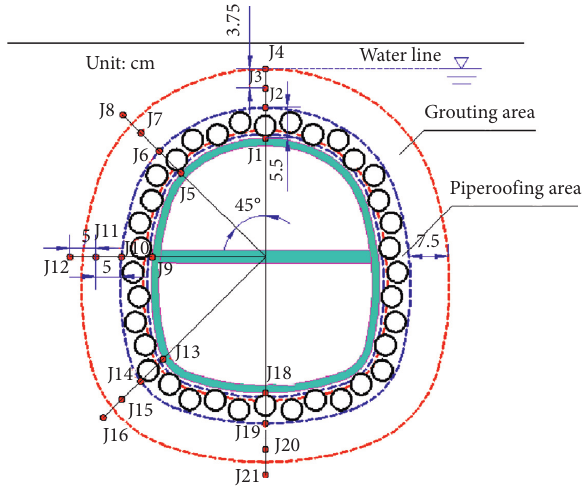
Figure 16: Layout of the water pressure measuring